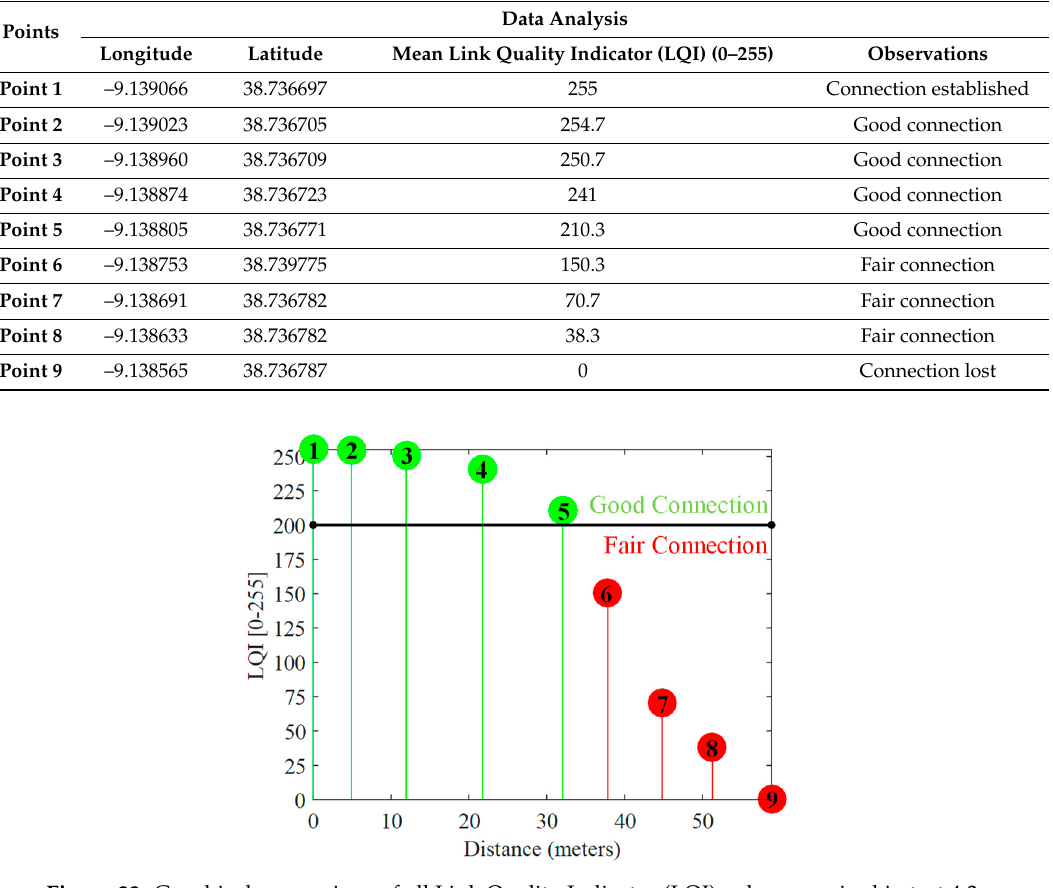
Figure 22. Graphical comparison of all Link Quality Indicator (LQI) values acquired in test 4.3.